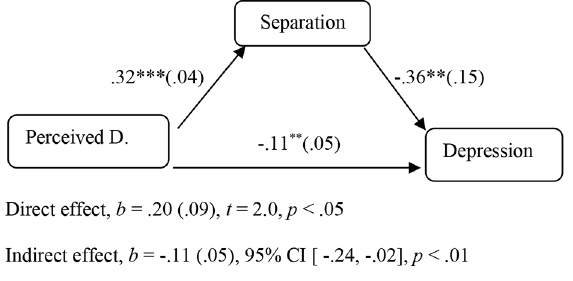
Note . Perceived D. = Perceived Discrimination.